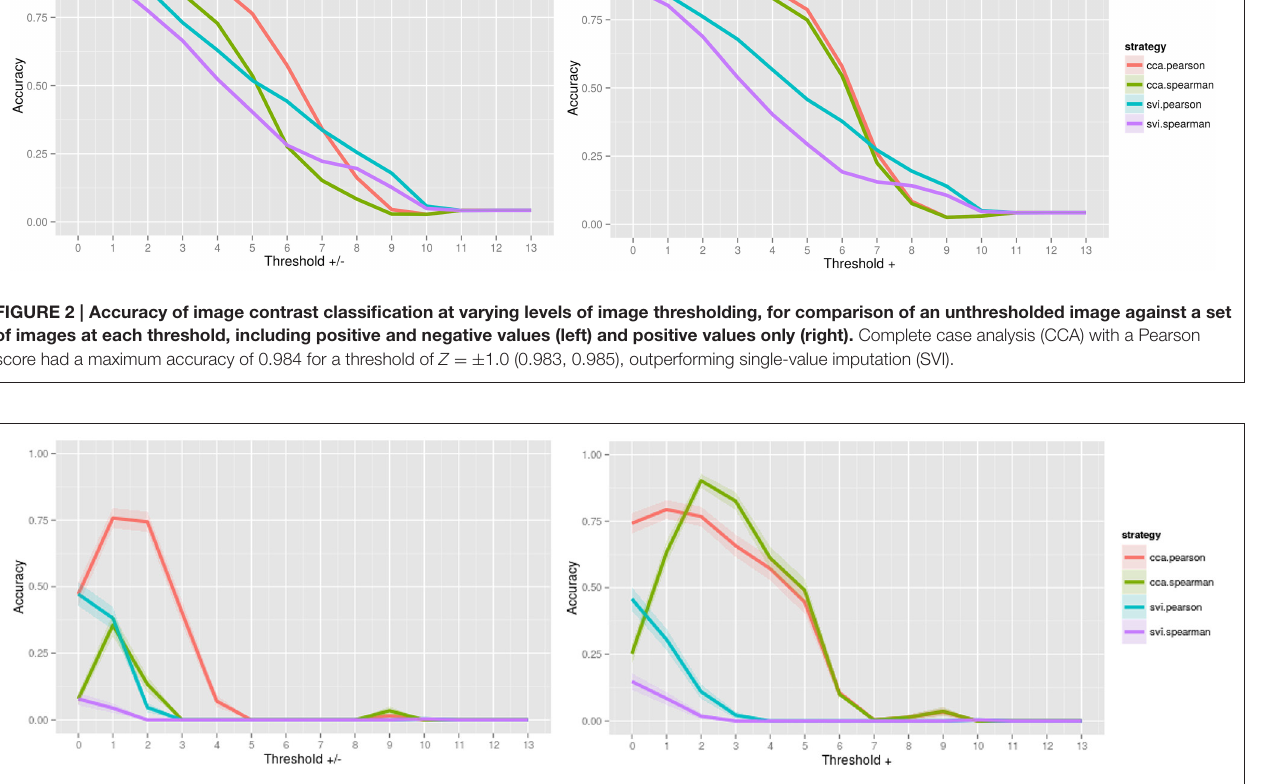
FIGURE 3 | Accuracy of image contrast classification at varying levels of thresholding, for the worst performing image, “0-back body,” from the working memory task. Accuracy peaked at a threshold of Z = ± 1.0 for complete case analysis with a Pearson score and at a threshold of Z = + 2.0 for complete case analysis with a Spearman score for each of positive and negative values (left) and positive values only (right).